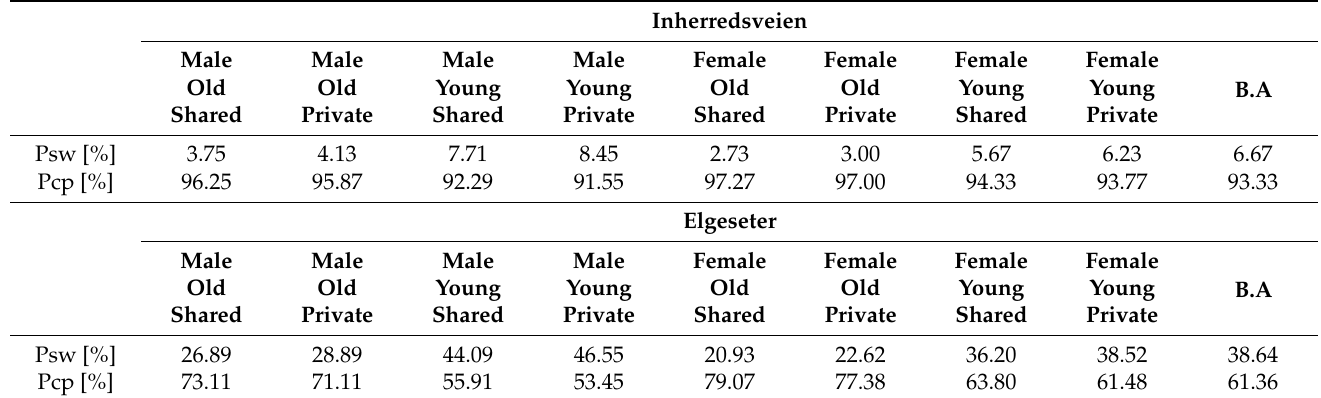
Table 10. Probability to choose the cycle path (Pcp) and sidewalk (Psw).